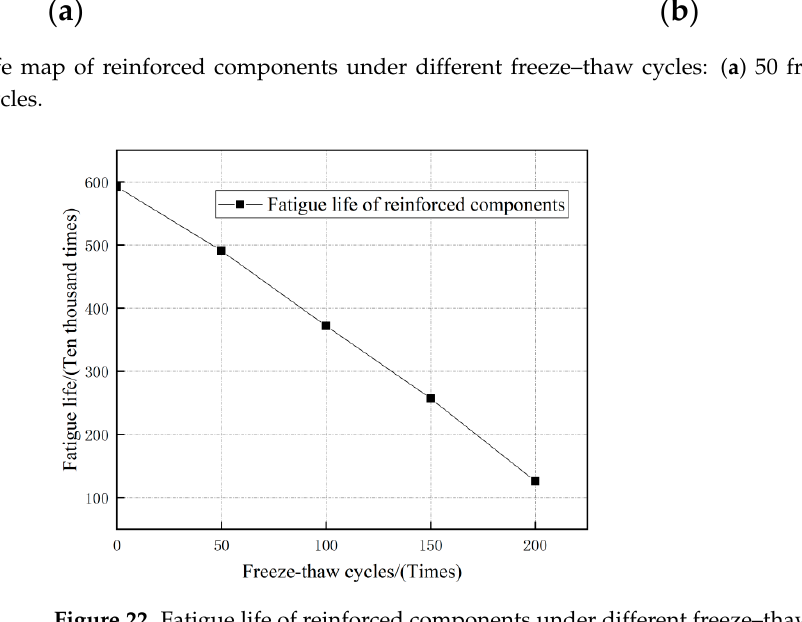
Figure 22. Fatigue life of reinforced components under different freeze–thaw cycles.